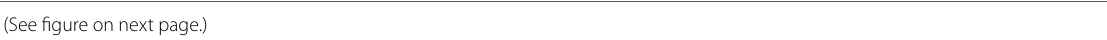
(See figure on next page.) Fig. 3 Results of resistivity and IP measurements, compared with porosity, clay content, and sulfide content, for a site C9017, b site C9021, and c site C9023. Note that sulfide content is defined as the total sum of identified sulfides without less‑conductive